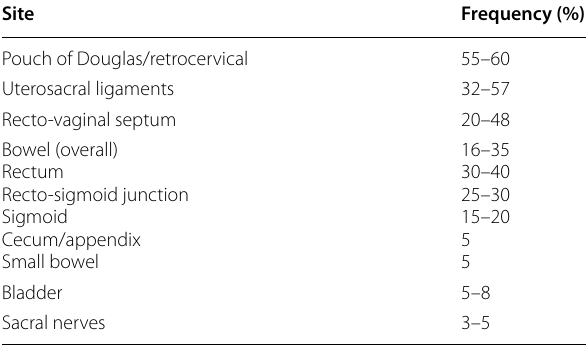
Table 1 Most frequent pelvic localization of